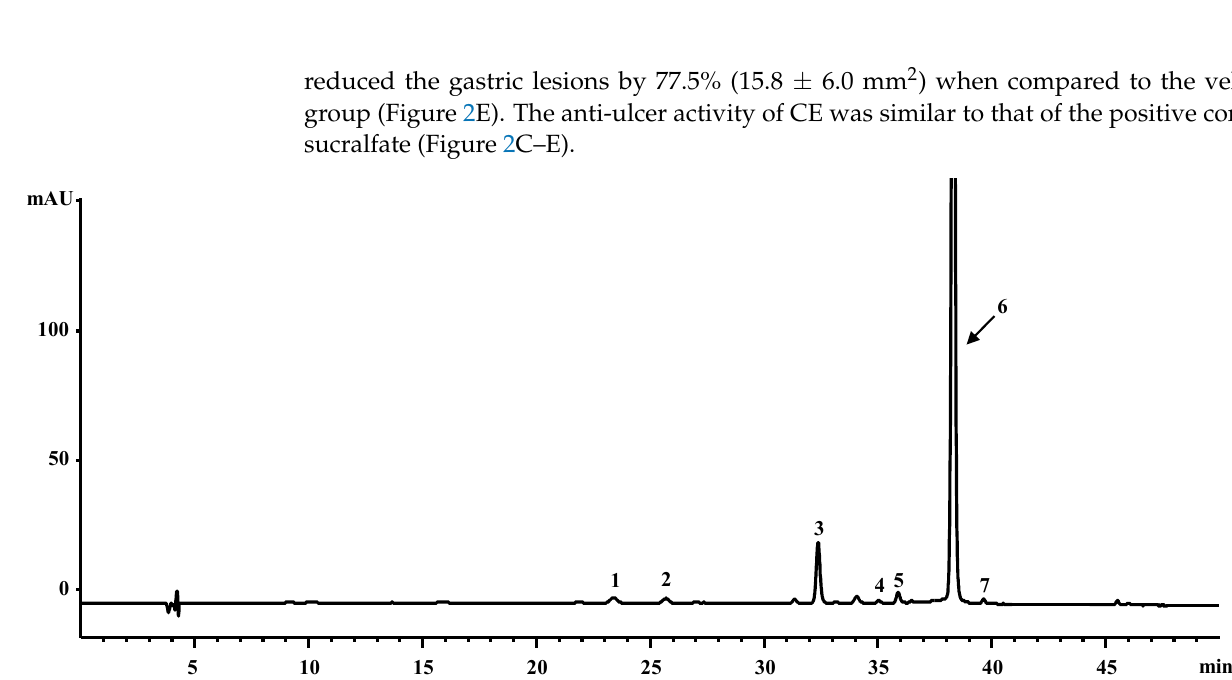
3 of 12 Figure 1. HPLC chromatogram of carotenoid extract (CE) from orange-fleshed sweet potato. 1 , lutein; 2 , zeaxanthin; 3 , ꞵ -